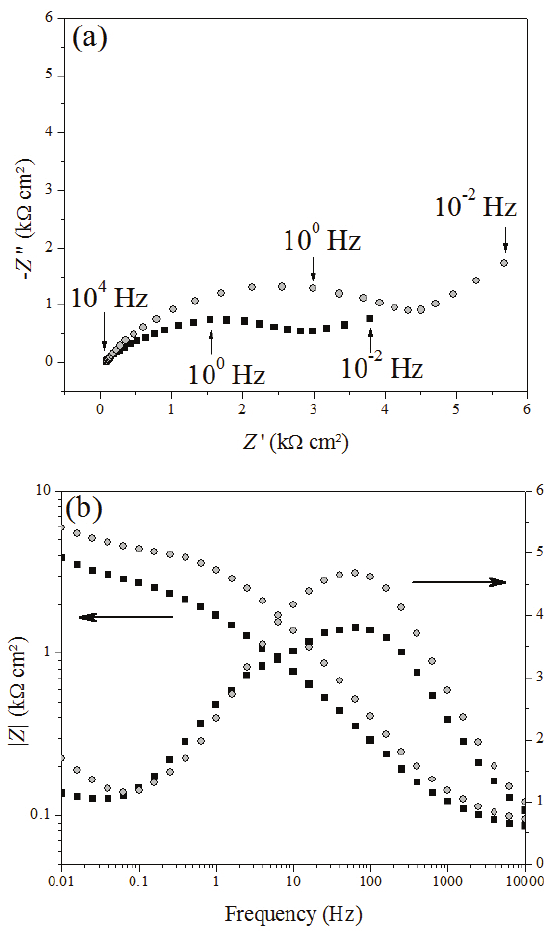
Fig. 6 – Nyquist plot (a) and Bode plot (b) of magnitude of impedance and phase angle of the TiO (■) and after (●) its exposure to the analyte of interest at 20 µg mL –1 in 0.01 M Tris buffer (pH 7.4)